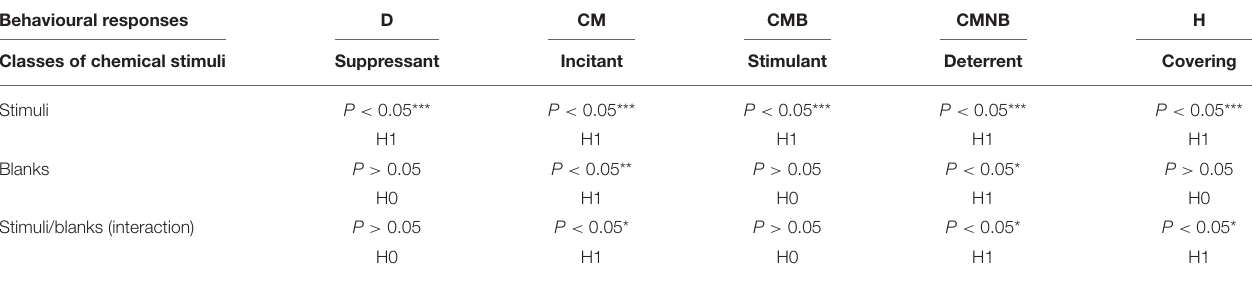
TABLE 5 | Differences in stimuli means with and without